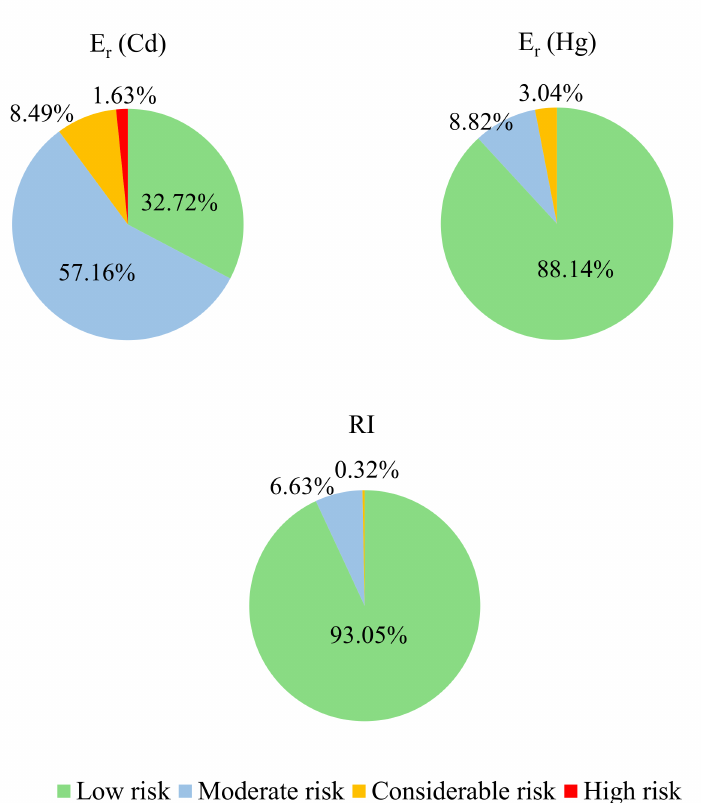
Figure 6. Percentage contributions of Cd and Hg to E i r and RI for heavy metals in